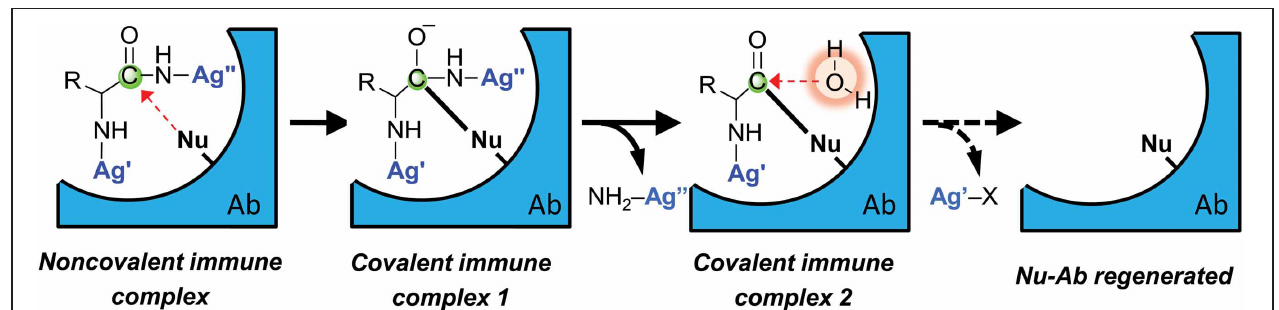
FIGURE 6 | Schematic representation of irreversible antigen (Ag) binding and catalytic Ag hydrolysis by a nucleophilic antibody (Ab). Specificity is derived from non-covalent epitope–paratope binding. The antibody nucleophile (Nu) attacks the weakly electrophilic peptide bond carbonyl. Covalent immune complex 1 is a resonant stable complex formed prior to